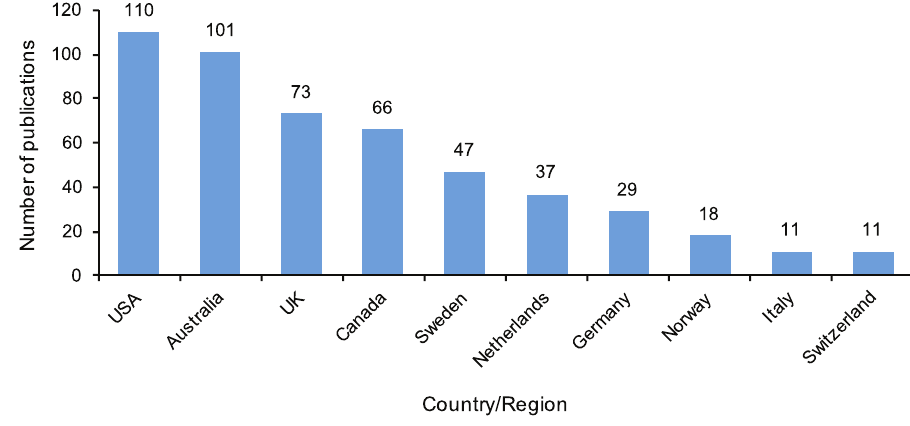
Figure 1: Information of countries and regions that contributed over 10 citations to Research Frontier 1.